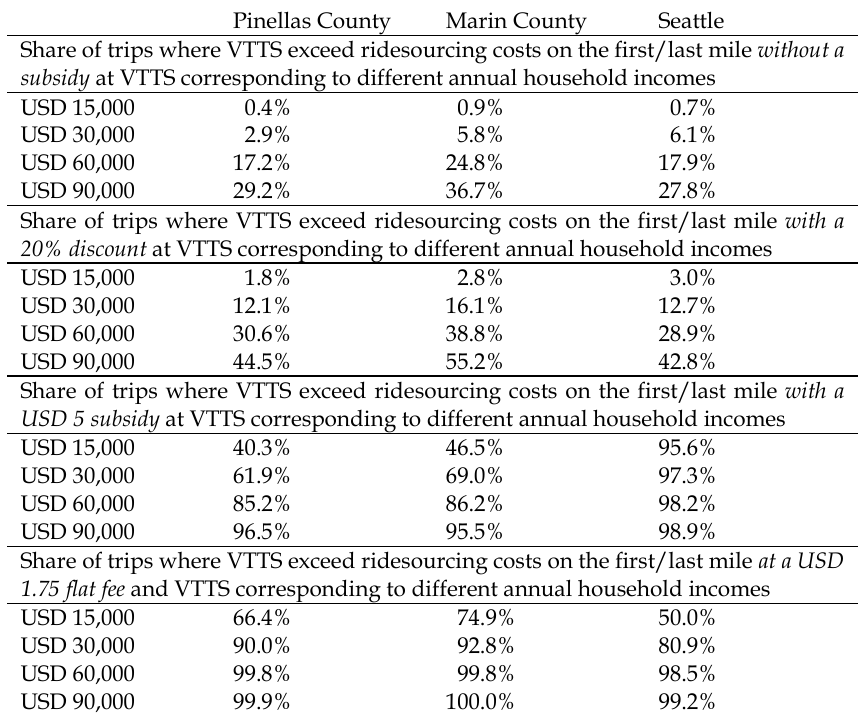
mile for different household incomes at different subsidy